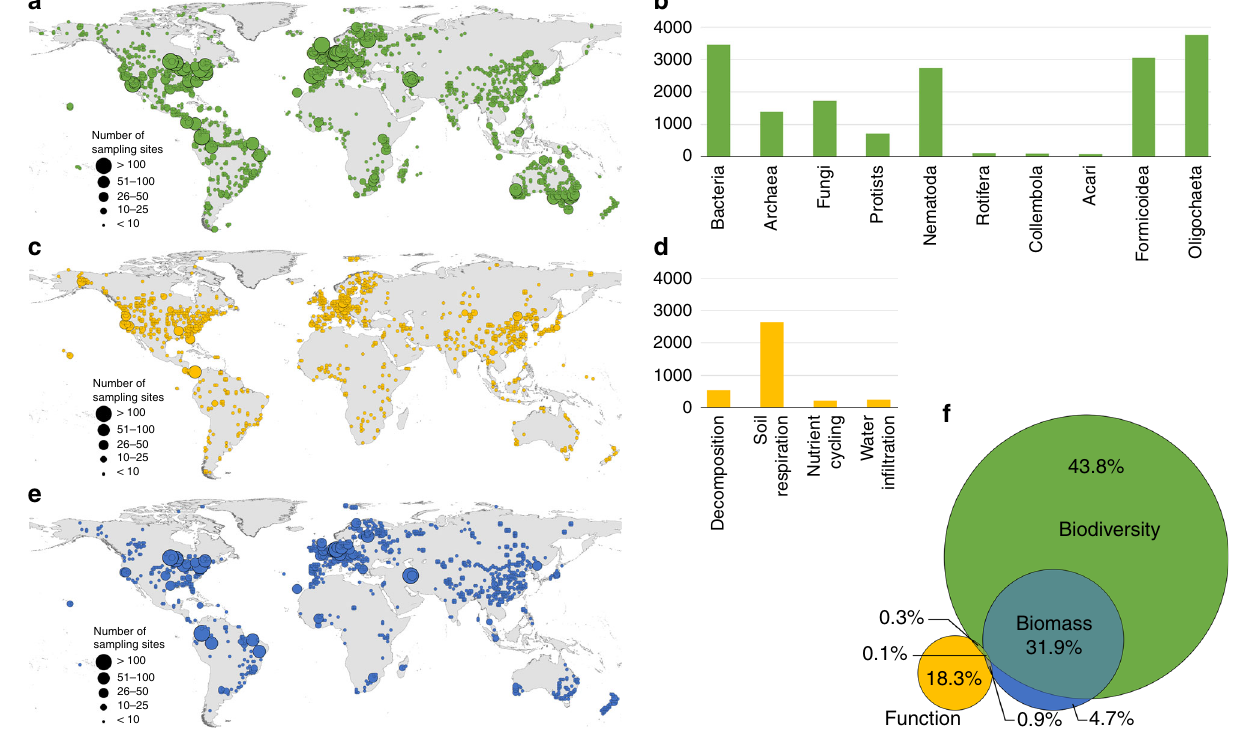
Fig. 1 Global distribution of sampling sites for soil taxa and soil ecosystem functions. a , b correspond to the global number of individual sampling sites for each soil taxon, c , d to the distribution of ecosystem functions, and e to the distribution of samples with biomass data. The venn diagram ( f ) indicates the proportion of sampling sites for soil taxa (in green), functions (in yellow), and biomass (in blue), and the 0.3% ( N = 63) of overlap between biodiversity and function data points (this number does not mean that soil biodiversity and function were assessed in the same soil sample or during the same sampling campaign; i.e., there are thematic or temporal mismatches, see Supplementary Fig. 11 for more details), relative to the total number of sampling sites covered by the studies. The maps show the overall spatial distribution of sampling sites for all taxa ( a ) and soil ecosystem functions ( c ). The size of the circles corresponds to the number of sampling sites within a 1° grid ranging from <10 to >50. All supporting data at: 10.6084/m9. fi